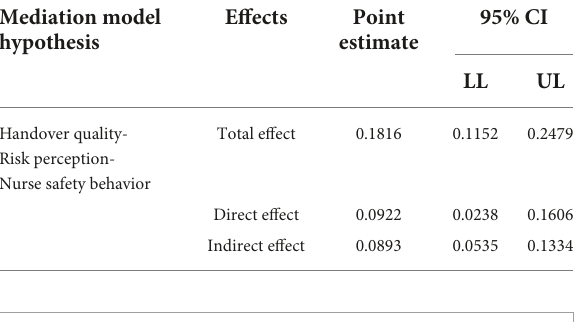
TABLE 3 Hierarchical linear regression analysis results.